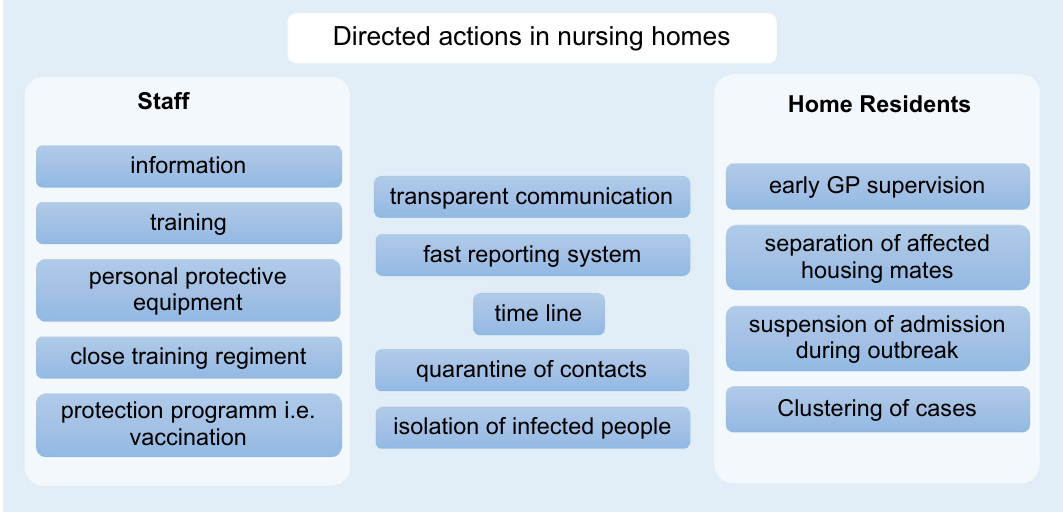
Figure 13. Directed actions in nursing homes in the event of an outbreak. Summary of our comparative analysis of the impact of actions in three different nursing homes. The conclusions indicate the area of conflicts between staff, home residents and the local public health